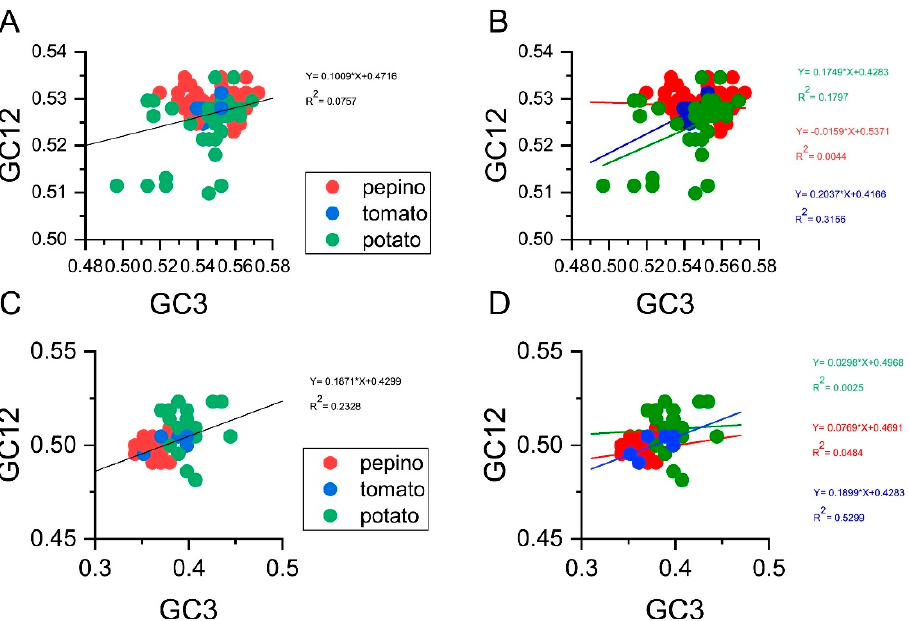
Figure 5. Neutrality plot analysis of GC3s against GC12s for all the coding sequences ( A ) and different hosts ( B ) based on the CP gene, and that for the coding sequences ( C ) and different hosts ( D ) based on the NABP genes, respectively. The pepino, potato and tomato hosts are represented in red, green and blue dots, respectively.